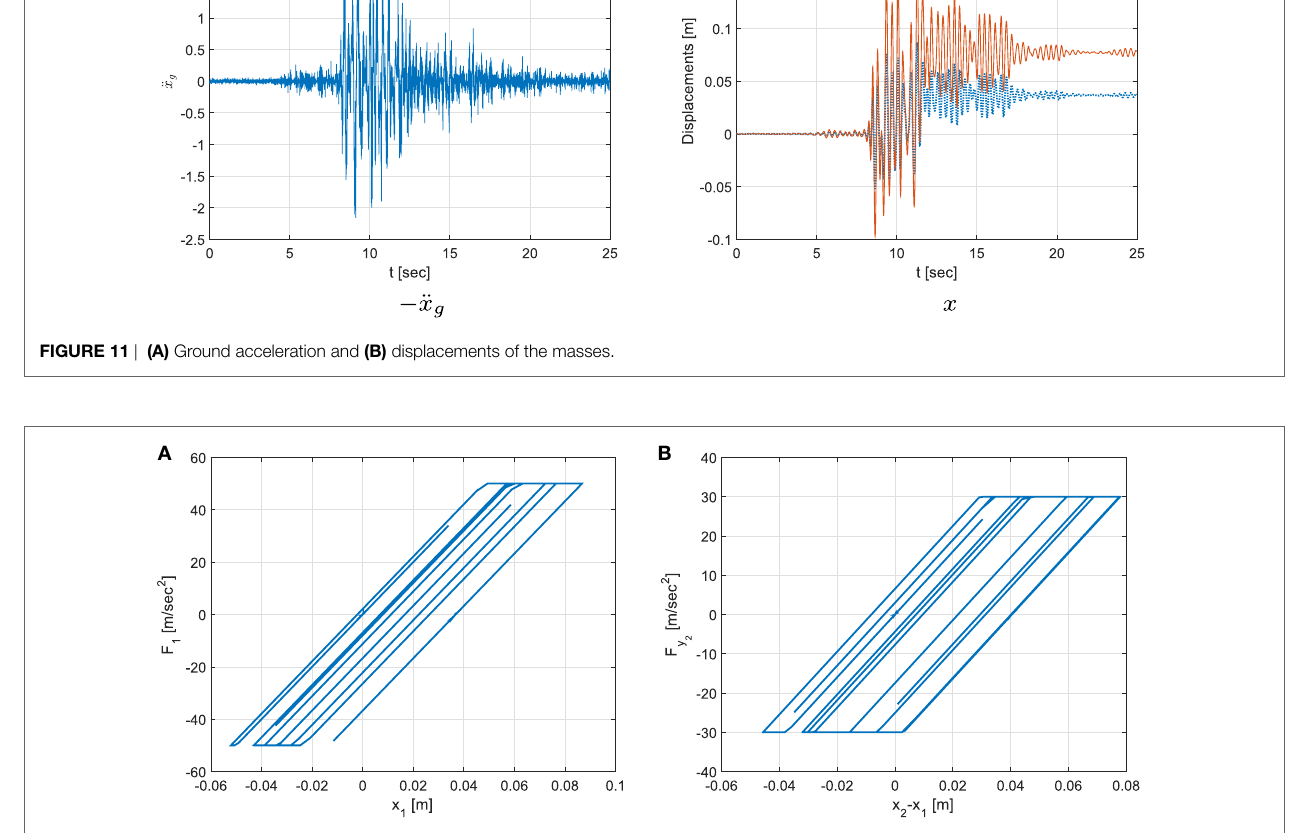
FIGURE 12 | Force displacement curves for (A) Spring 1 and (B) Spring 2.